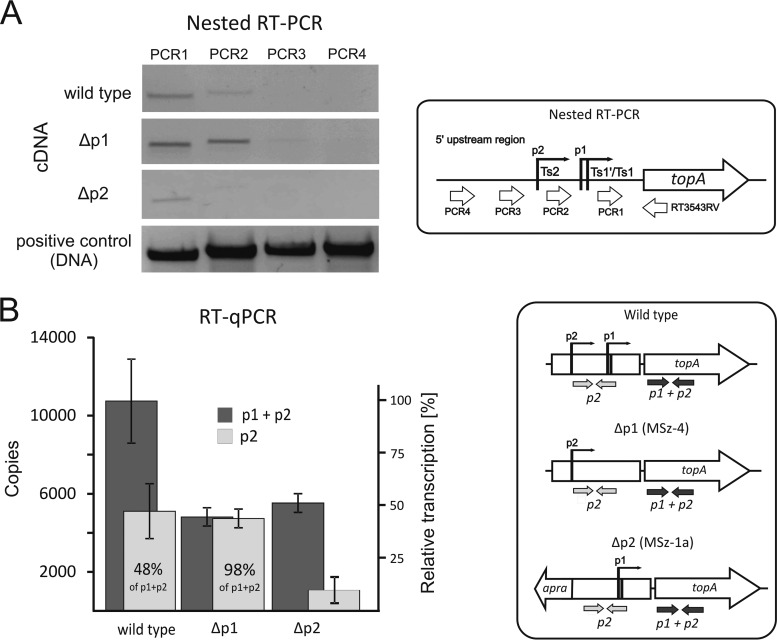
Contribution of the topA promoter to the total transcript level. (A) Nested RT-PCR using oligonucleotides complementary to the upstream region of the topA promoter (see the scheme at right). For the wild-type strain, the two bands (PCR1 and PCR2) correspond to the products of the p1 and p2 promoters (see the scheme at right). (B) RT-qPCR analysis of RNAs isolated from the wild-type strain and the p1 and p2 mutants. Oligonucleotides were designed to detect the overall topA transcript (p1 + p2) and p2-specific transcript (p2) levels (see the scheme at right).